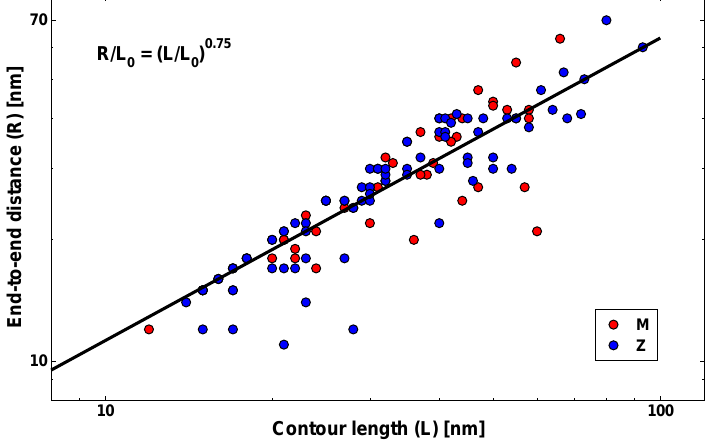
Figure 4. End-to-end distance (R) versus contour length (L) for M (red circles) and Z (blue circles) α 1 AT. The solid line represents a power law with exponent